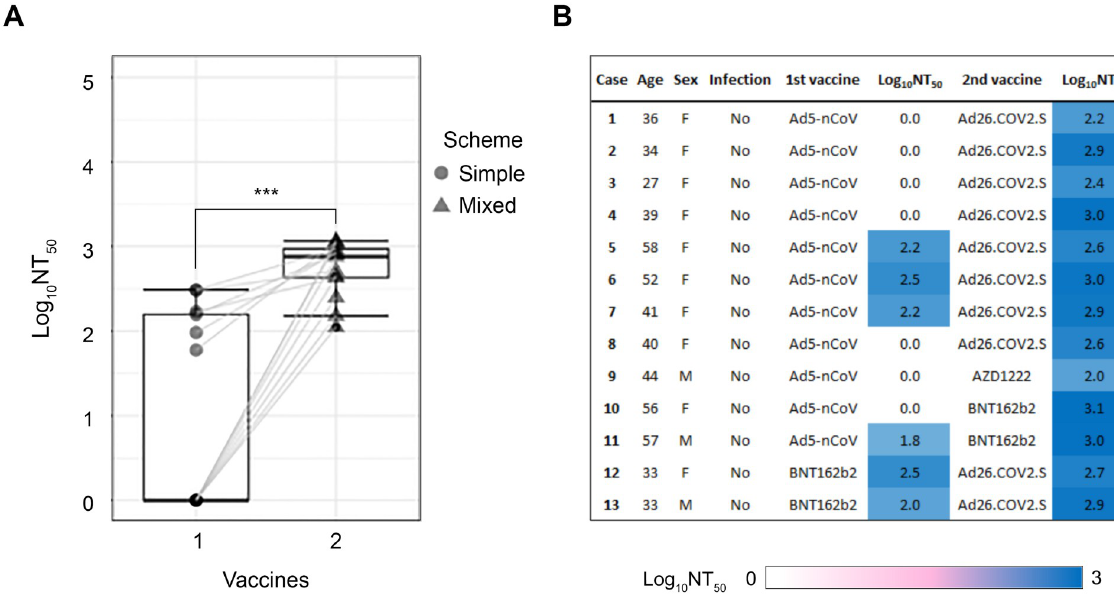
Fig 4. The NAb titers increase in all cases when a second vaccine is received. A) Box plot and tracing of 13 cases before and after mixing vaccines. B) Description of the cases with mixed vaccines. The Log 10 N 50 titers are highlighted by a color scale from white to blue, corresponding from the lowest to the highest NAb